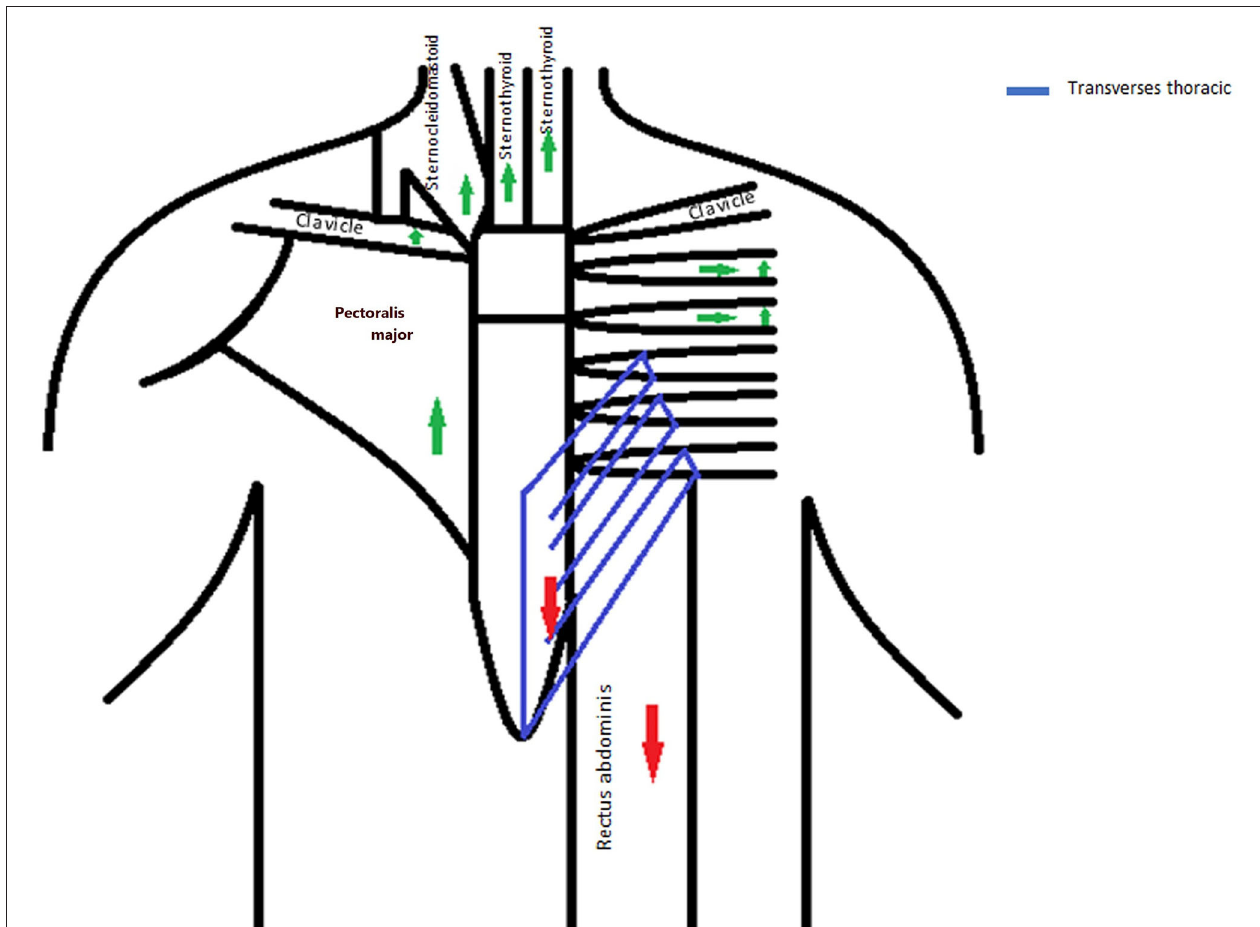
FIGURE 2 | Anatomical forces acting on the manubriosternal